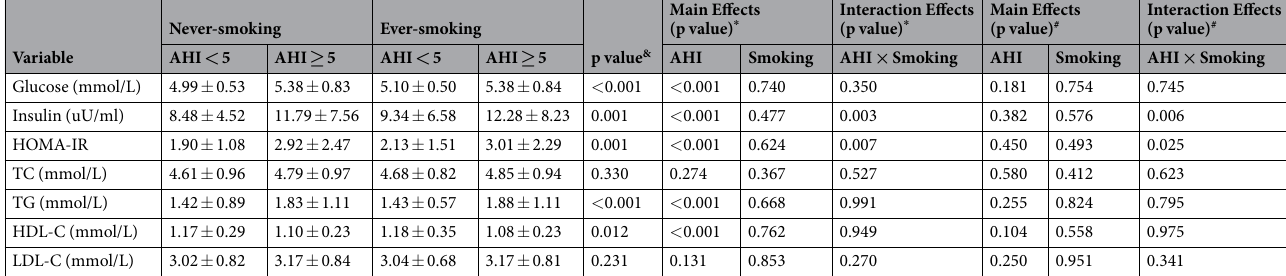
Table 5. Markers of metabolic outcomes in never-smoking and ever-smoking OSAS patients. Abbreviations: HOMA-IR, homeostasis model of assessment for insulin resistance index; AHI, apnea-hypopnea index; OSAS, obstructive sleep apnea syndrome; TC, total cholesterol; TG, triglyceride; HDL-C, high density lipoprotein cholesterol; LDL-C, low density lipoprotein cholesterol. & p value indicates overall comparison. * p value without adjustment. # p value adjusted for age, BMI,WHR and ESS.